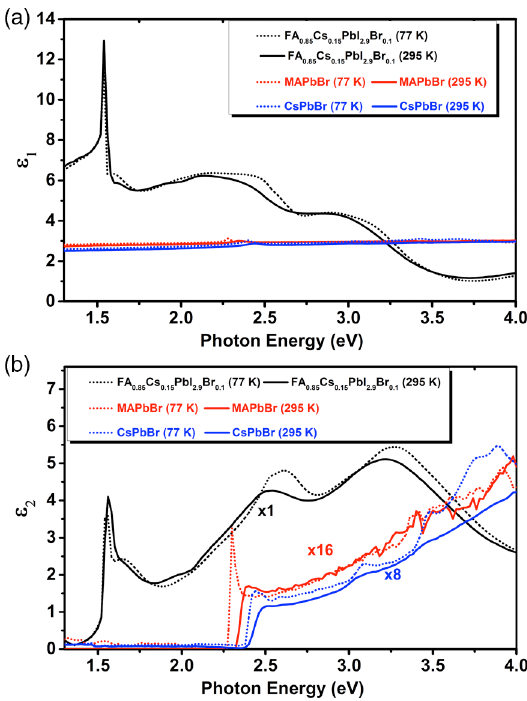
FIG. 1. (a) Comparison of ε 1 for FA 0 MAPbBr 3 , and CsPbBr 3 at 77 K and 295 K. (b) Comparison of the normalized exciton amplitude in ε 2 for FA 0 PbI 2 Br 0 , MAPbBr 3 , and CsPbBr 3 at 77 K and 295 K. The . 9 . 1 ε 2 data for all of the materials have been normalized, whereby the CsPbBr 3 data were increased by a factor of 8 and the MAPbBr 3 data were increased by a factor of